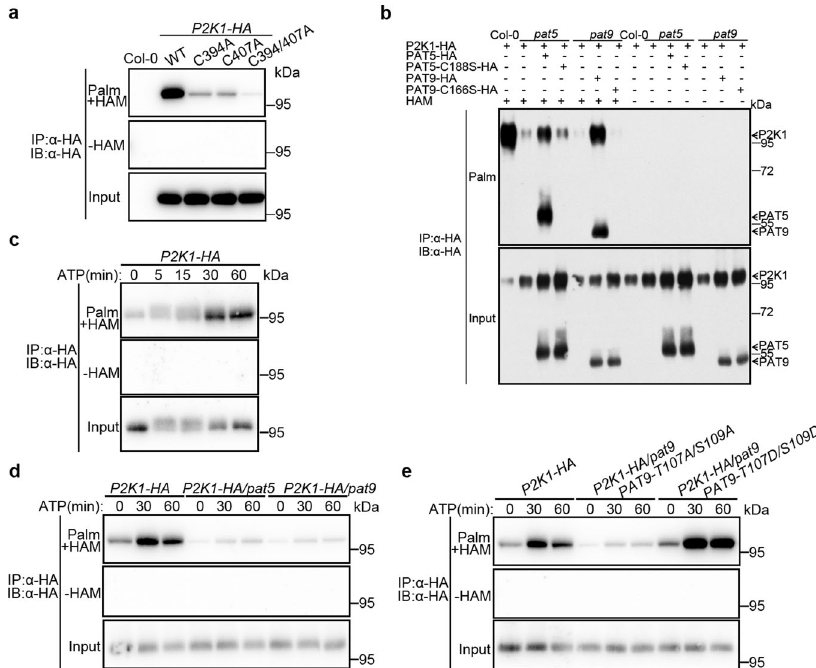
Fig. 4 PAT5 and PAT9 S -acylate P2K1. a Detection of P2K1 S -acylation and their associated residues in the stable P2K1-HA transgenic plants. The S - acylation levels were detected by an acyl-resin capture (acyl-RAC) assay. Palm- palmitoylated protein, Depalm- depalmitoylated protein. HAM, hydroxylamine, for cleavage of the Cys-palmitoyl thioester linkages. Experiments were repeated three times. b PAT5 and PAT9 S -acylate P2K1 in planta . Protoplasts of Arabidopsis wild-type Col-0, Atpat5 and Atpat9 mutants were transfected with plasmids as indicated, followed by acyl-RAC assays. Experiments were repeated three times. c – e Dynamic S -acylation levels of P2K1 in stable transgenic plants upon eATP addition. The P2K1-HA transgenic plant was crossed with pat5 , pat9 , NP::PAT9-T107/AS109A/pat9 , and NP::PAT9-T107D/S109D/pat9 plants and then in fi ltrated with 200 μ M ATP. All experiments were repeated and analyzed three times with similar